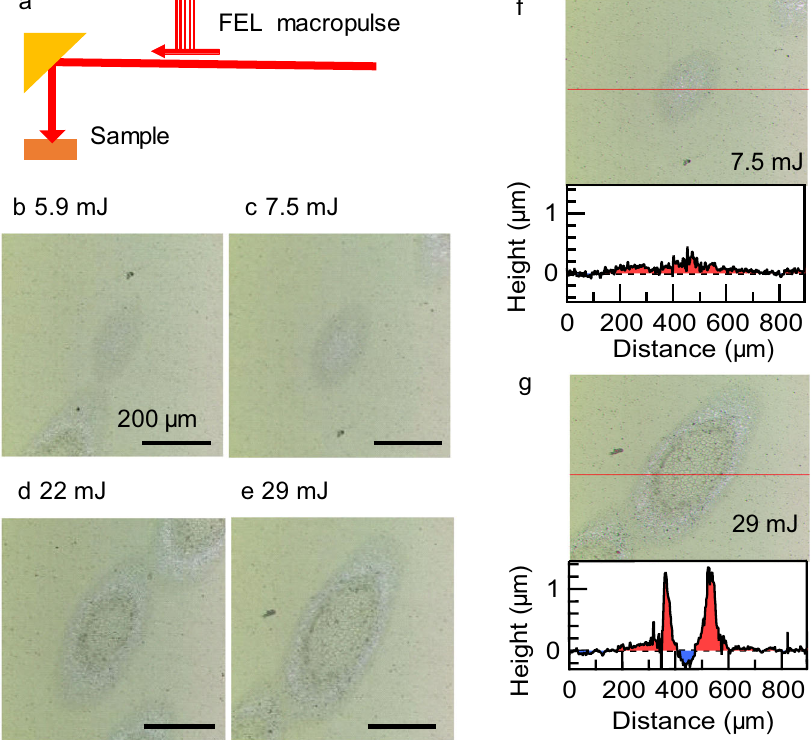
Fig. 2 Scars on the surface of the t-ZrO 2 sintered plate after irradiation with 4.2-THz pulses. a Schematic of our experimental setup. b – e Photographs of scars generated by single 4.2 THz pulses with different excitation pulse energies. f , g Two photographs of scars and the corresponding height pro fi les of the irradiation scar at the position indicated by the red line. Red and blue hatches represent rise and depressions in the irradiation spot,